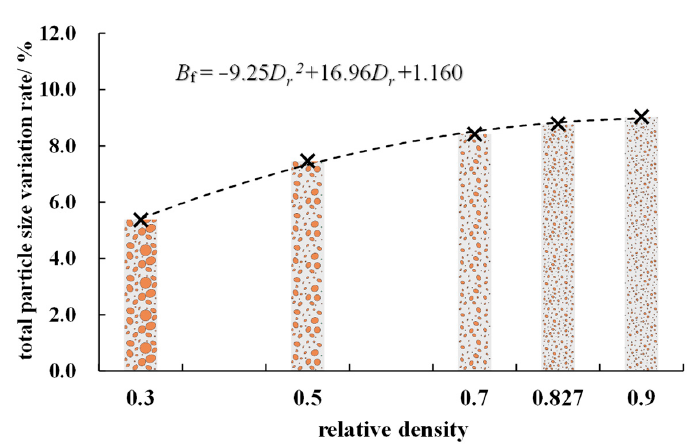
Figure 18. The effect of soil bulk density on the total particle size of silt.